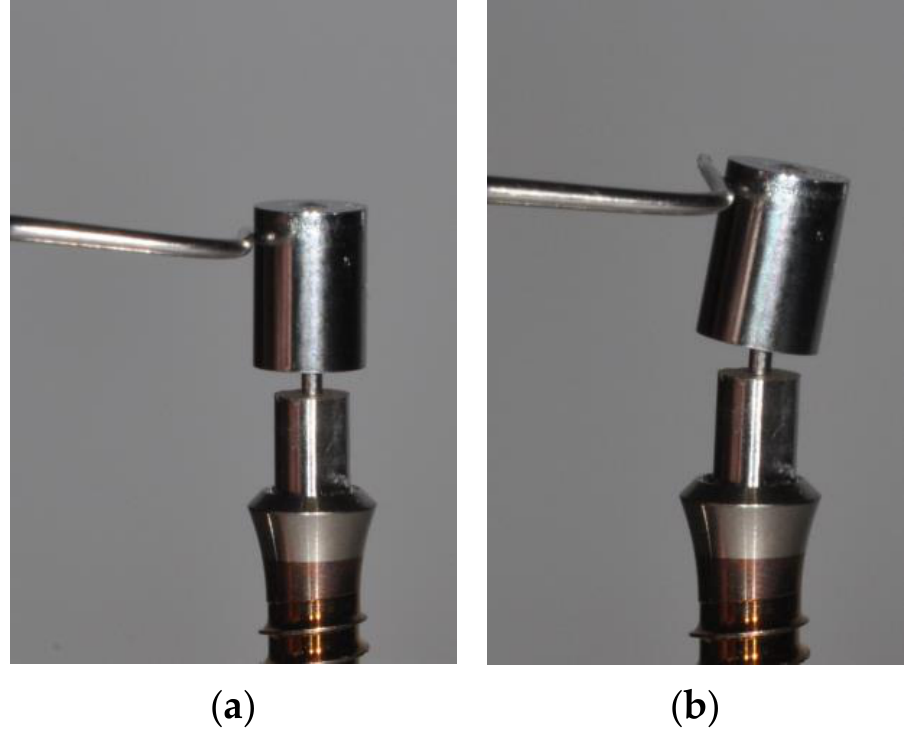
Figure 1. Prototype attachment system employing a cylindrical male attachment part connected to an abutment base via a 0.8 mm NiTi wire. ( a ) Attachment system mounted on an implant shoulder; ( b ) A horizontal force acting on the male attachment part causes a deflection relative to the base, which is supposed to compensate for misalignments of implants and transfer inaccuracies between patient situation and laboratory cast.